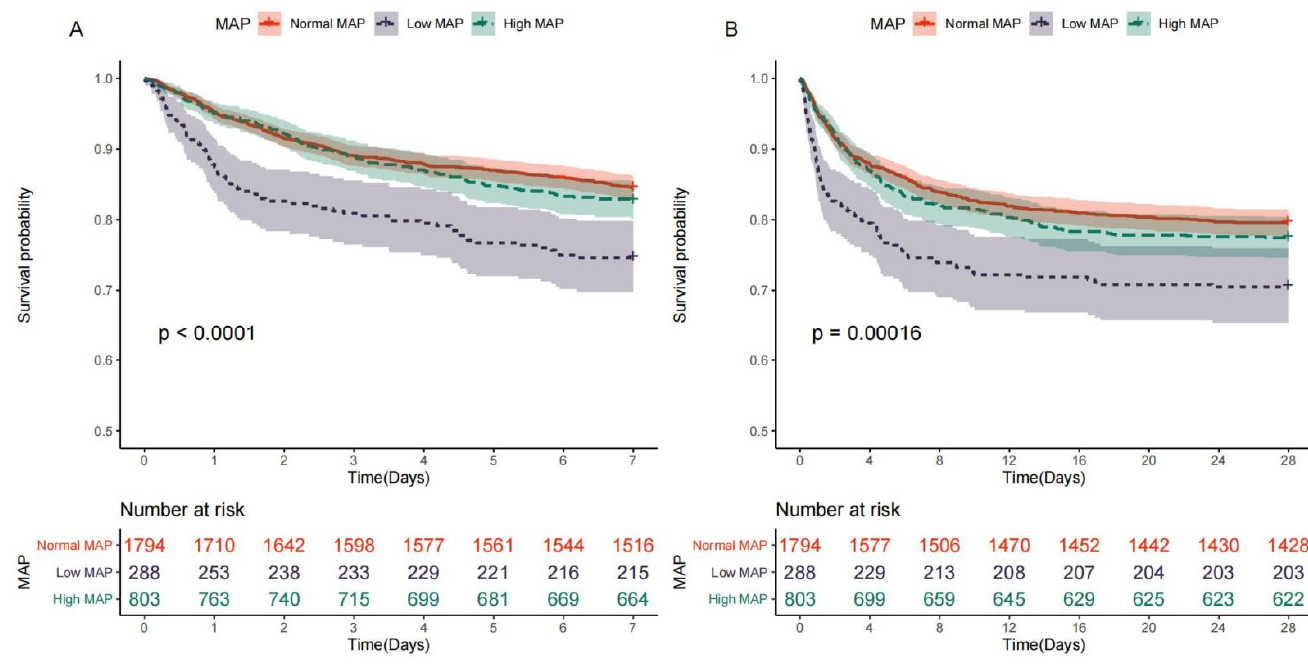
Figure 1. Kaplan-Meier (KM) survival curves for stroke patients with different ranges of MAP. ( A ) Kaplan–Meier survival curves for normal, high, and low MAP at day 7. ( B ) Kaplan–Meier survival curves for normal, high, and low MAP at day 28. Table 2. Association between MAP and outcomes of stroke patients adjusted by multivariable Cox proportional hazards models.